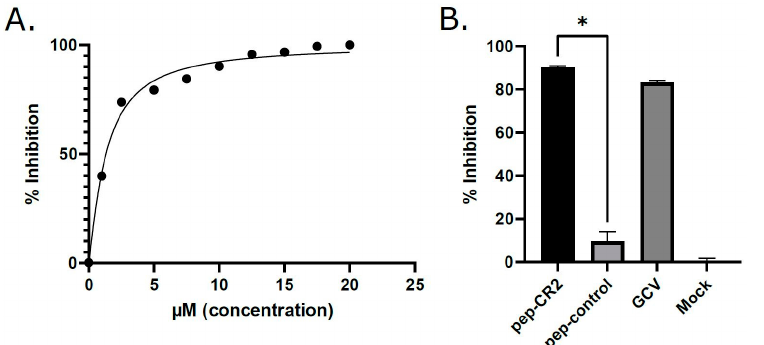
Figure 4. ( A ) Determining the IC 50 (half-maximal inhibitory concentration) of pep-CR2. HFFs were pretreated for 1 h with different concentrations of pep-CR2 (1 μ M, 2.5 μ M, 5 μ M, 7.5 μ M, 10 μ M, 12.5 μ M, 15 μ M, 17.5 μ M and 20 μ M), pep-control, ganciclovir (GCV) or mock (in triplicates) and then infected with HCMV at a low MOI of 0.1. Cells were fixed at 10 dpi, and virus yield was meas- ured by counting the number of plaques. The percentage inhibition of pep-CR2 is plotted against concentration range of 1 μ M-20 μ M. The IC 50 of pep-CR2 was calculated to be 1.33 μ M with a 95% confidence interval of 1.182 to 1.474 μ M. ( B ) Comparing inhibition of virus growth by pep-CR2, pep-control, GCV and no-treatment control (Mock) at 10 μ M concentration. Pep-CR2 treated cells showed ~90% inhibition in virus growth compared to the controls. Data were analyzed by Student’s t -tests, comparing the means of control and treatment groups. Standard error of mean was plotted as error bars. A p value of <0.05 was considered significant. An asterisk (*) indicates significant in- hibition compared to wild type. To study the localization of pp150 in pep-CR2- and pep-control-treated infected cells, HFFs were pretreated with pep-CR2 or pep-control, as described earlier, and then infected with a strain of HCMV where pp150 is fused with GFP (BAD32, MOI 3.0) [20]. Cells were fixed and imaged by epifluorescent microscopy at 4 dpi. These localization studies showed that pep-CR2-treated cells contain a diffused GFP signal in the cytoplasm of in- fected cells in contrast to a solid juxtanuclear sphere of GFP, which corresponds to vAC in the pep-control-treated cells (Figure 6). The intensity of the GFP signal was much higher in the nucleus of pep-CR2-treated cells compared to the nucleus of the pep-control-treated cells. These results indicate that pep-CR2 may be compromising virion maturation by se- questering pp150 in the nucleus of infected cells and interfering with the organization of the vAC.